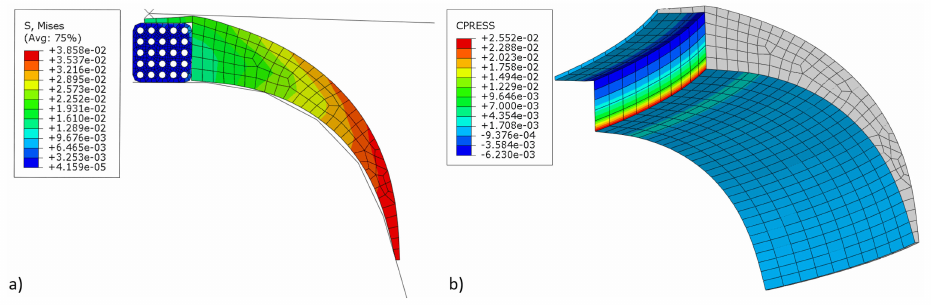
Figure 13. Simulation results after optimization: ( a ) von Mises stress (MPa); ( b ) contact pressure on the apex